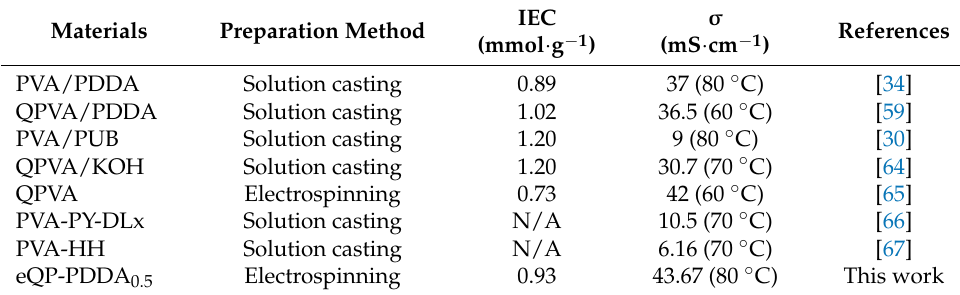
Table 4. Reported IEC and OH − conductivity for PVA-based AEMs at 60 – 80 °C.